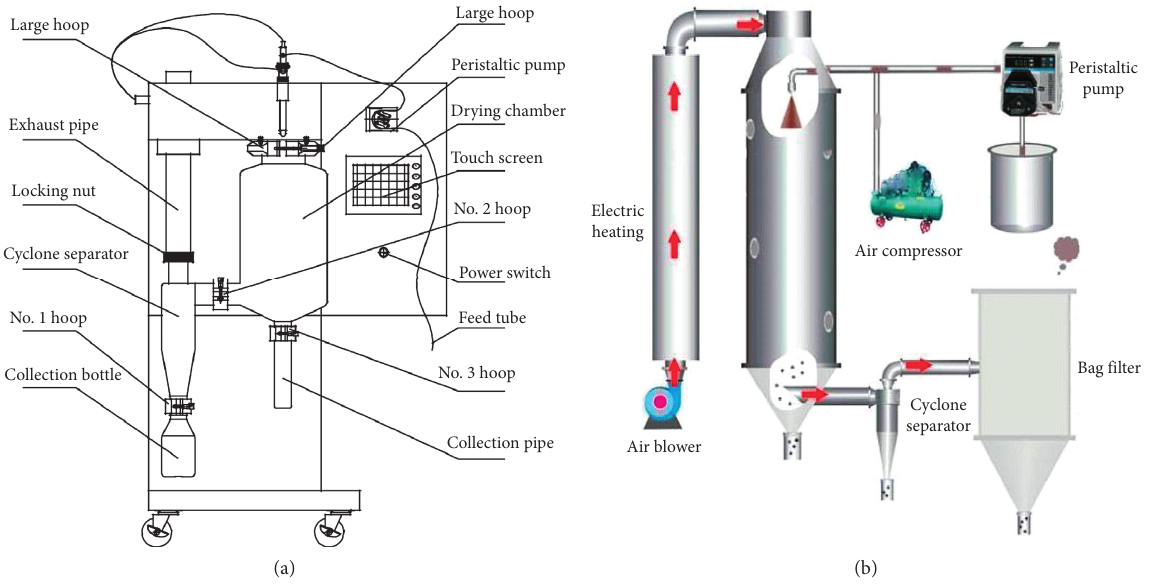
Figure 1: The schematic diagram of the lab-scale spray-dryer. Table 1: Coded and actual levels of independent variables for optimization of response factors as determined by Box–Behnken